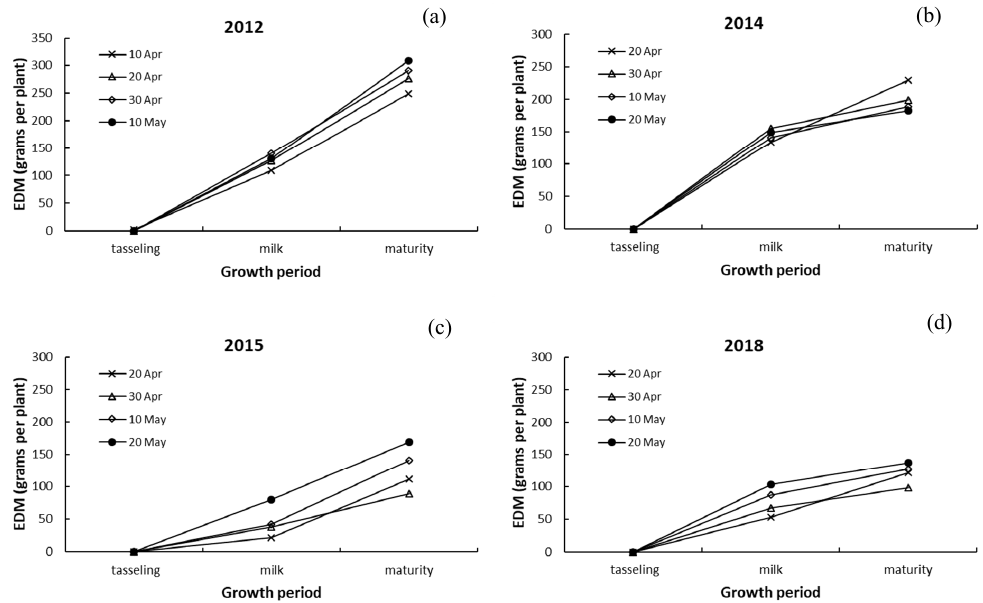
Figure 7. Variations in EDM with development stages for different treatments in each year: ( a ) 2012, ( b ) 2014, ( c ) 2015, ( d ) 2018.